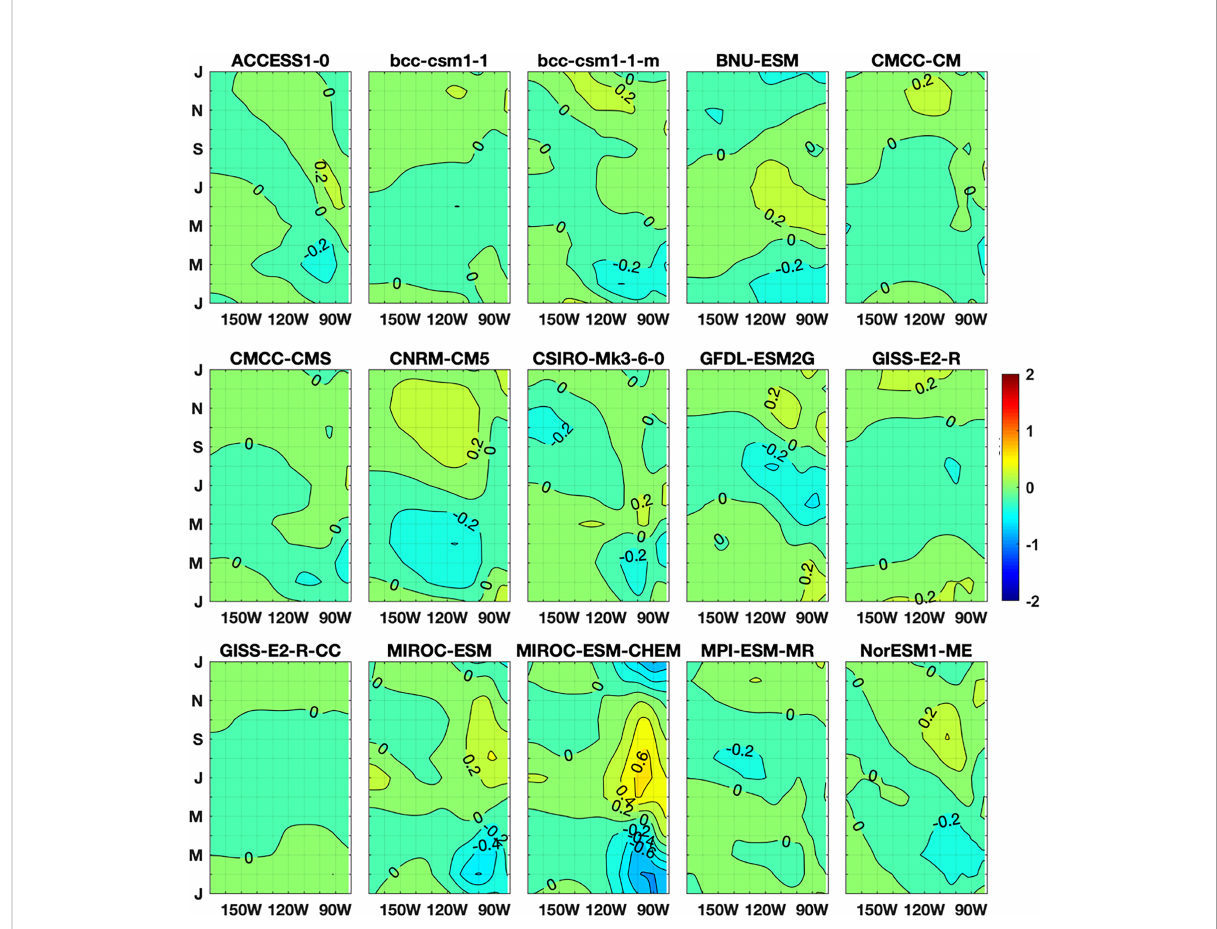
FIGURE 3 Same as Figure 1D, but for the difference between historical and RCP4.5 (where the difference is calculated as RCP4.5 minus